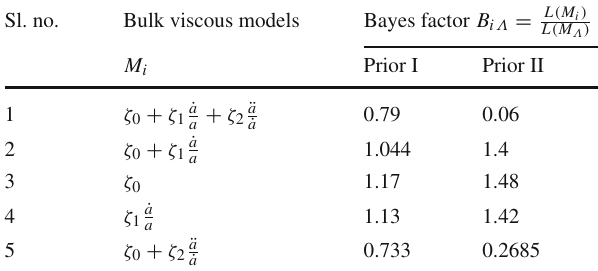
Table 4 Bayes factors with respect to Λ CDM model corresponding to two different priors for high redshift Sl.